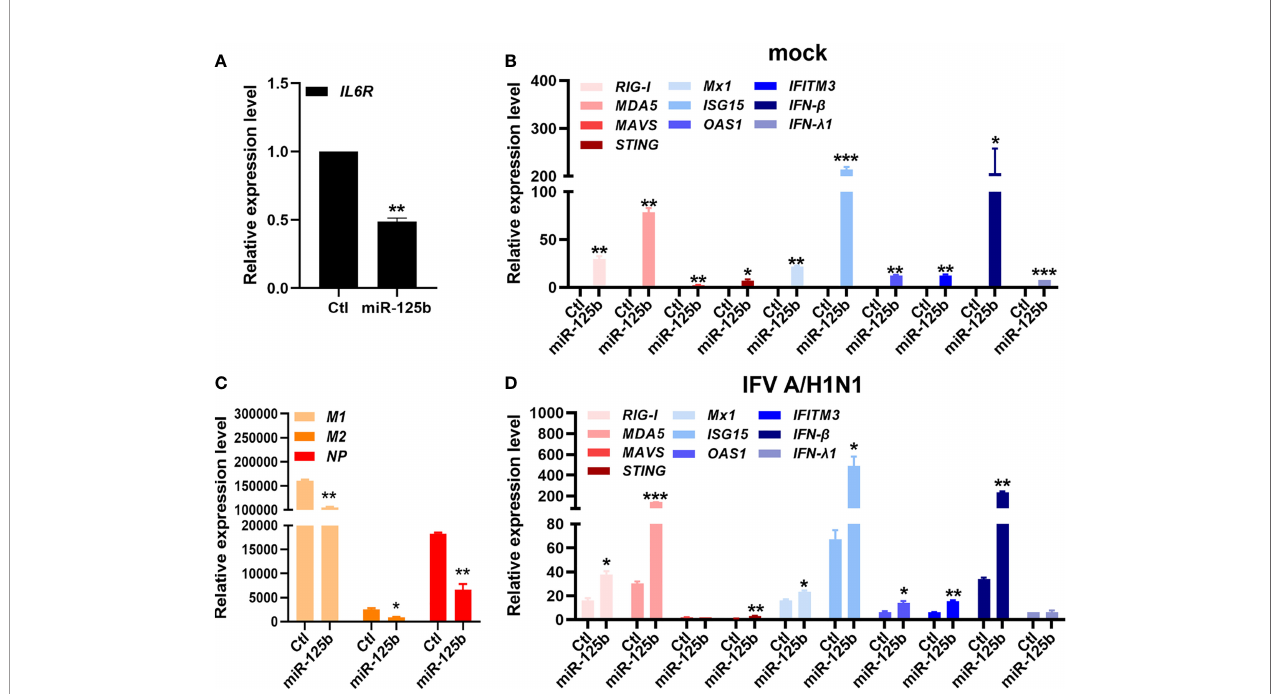
FIGURE 3 | miR-125b-5p, one of the highly expressed microRNAs (miRNAs) in U-exo, is capable of antiviral action against IFV. A549 cells were transfected with control mimic (Ctl) or miR-125b-5p mimic for 24 hours. The next day, cells were infected with mock or IFV A/H1N1 at an MOI of 1 and RNA was collected 48 h later. (A) The effect of miR-125-5p mimic was veri fi ed by quantitative measurement of IL-6R , which is previously shown to be a target of miR-125-5p. (B) Matrix protein 1 ( M1 ), matrix protein 2 ( M2 ) and nucleoprotein ( NP ) expression levels were quanti fi ed and normalized against GAPDH . (C, D) Host gene expressions ( retinoic acid- inducible gene-I (RIG-I), melanoma differentiation associated protein 5 (MDA5), mitochondria antiviral signaling protein (MAVS), Stimulator Of Interferon Response (STING), MX Dynamin Like GTPase 1 (Mx1), Interferon stimulated gene 15 (ISG15), O2 ’ -5 ’ -Oligoadenylate Synthetase 1 (OAS1), Interferon Induced Transmembrane Protein 3 (IFITM3), interferon beta (IFN- b ), and interferon lambda 1 (IFN- l 1) ), were also determined by RT-qPCR (means ± SD; n = 2). *p<0.05, **p<0.01, and ***p<0.001, when compared to